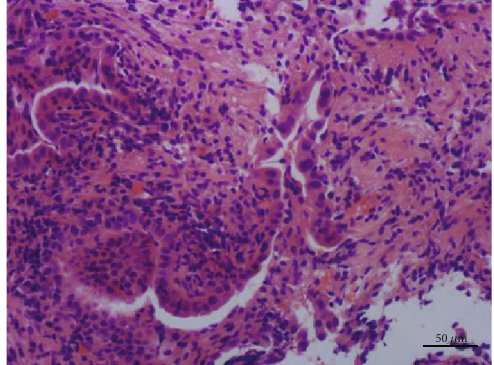
Figure 12: Papillary adenoma stained with CK7, × 100.